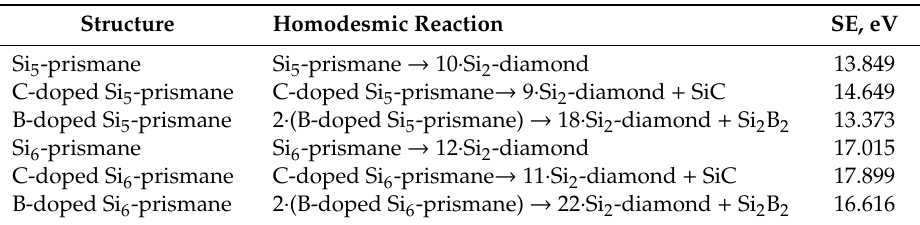
Table 2. Strain energies (SE) calculated from the homodesmic reactions for the pure and doped Si 5 and Si 6 polyprismanes.